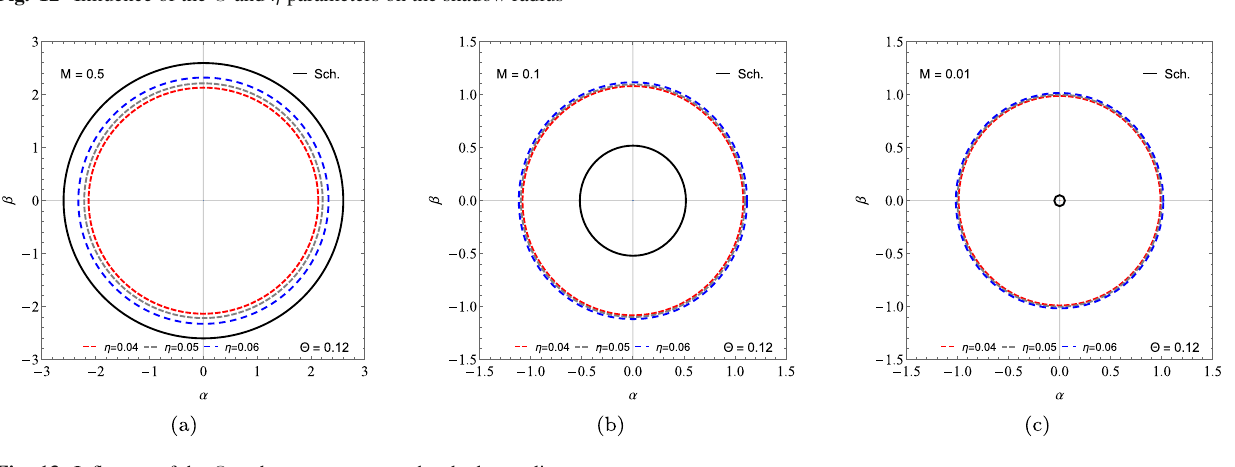
Fig. 13 Influence of the (cid:11) and η parameters on the shadow